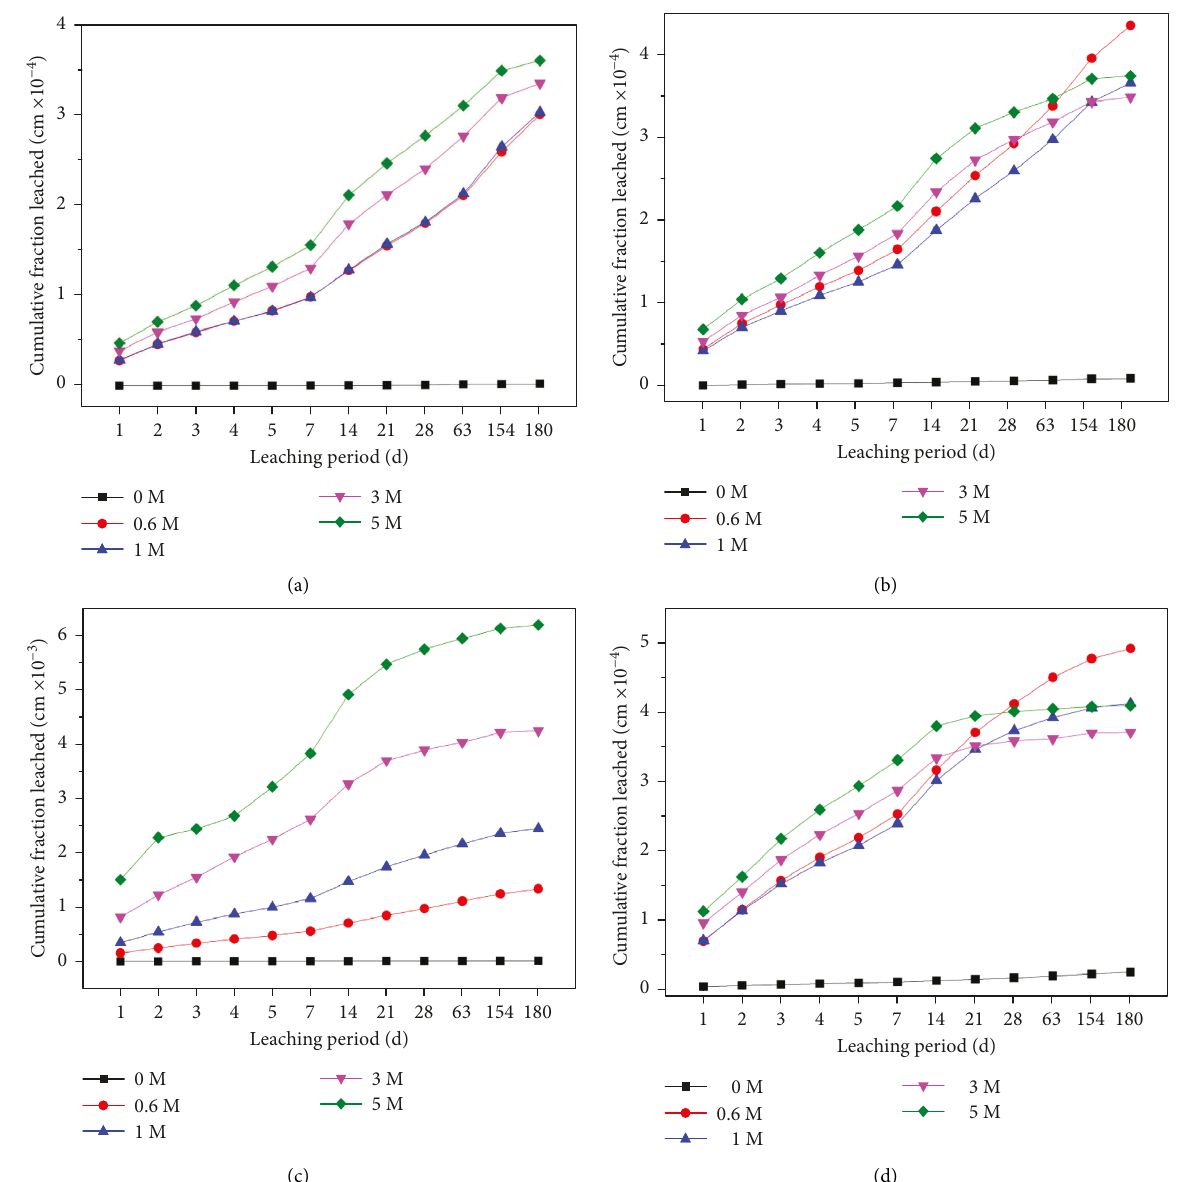
Figure 8: CFL of Cs + in fly ash/cement waste forms under simultaneous effect: (a) 20 ° C; (b) 40 ° C; (c) 60 ° C; (d) 80 °